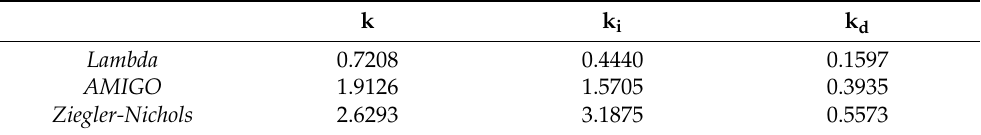
Table 5. PID parameters according to the average values from the step responses with an additional load of 4.7 g.